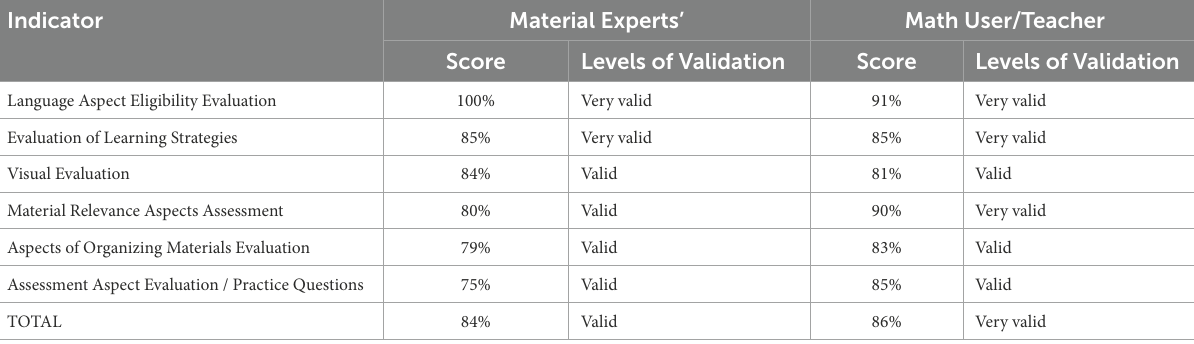
TABLE 6 Material expert and math user/teacher validation results are recapitulated.